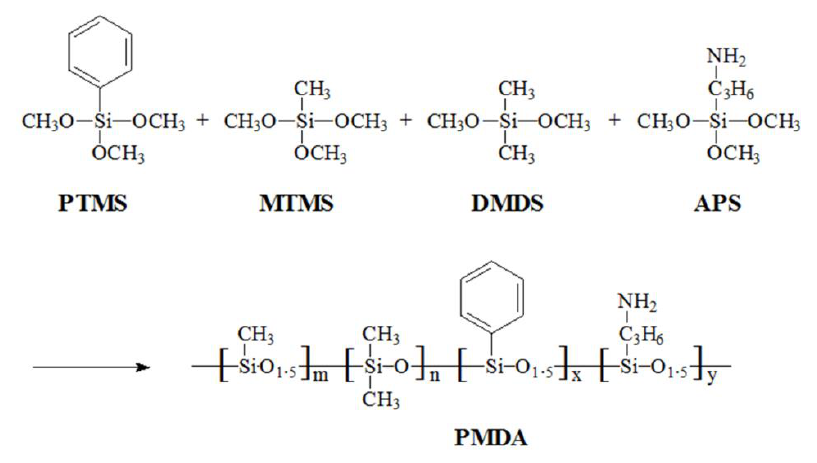
Figure 1. Synthesis of PMDA.